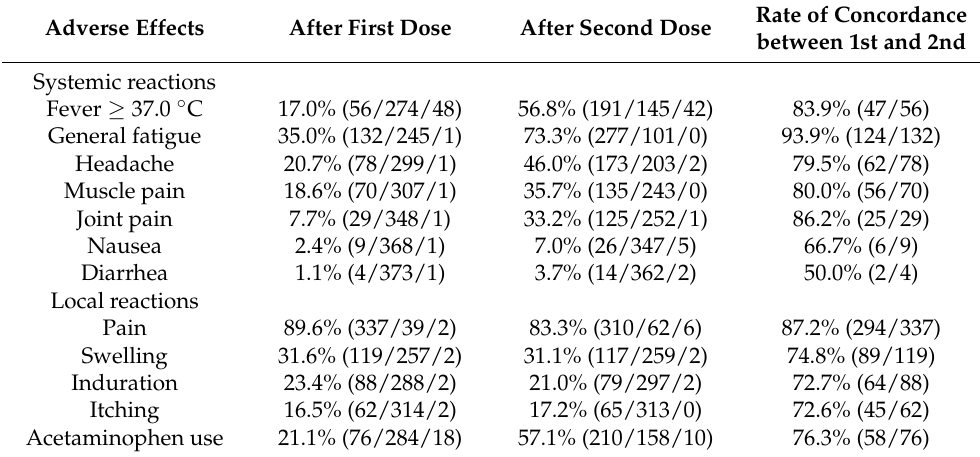
Table 1. Prevalence of adverse effects induced by the BNT162b2 vaccine ( n = 378).